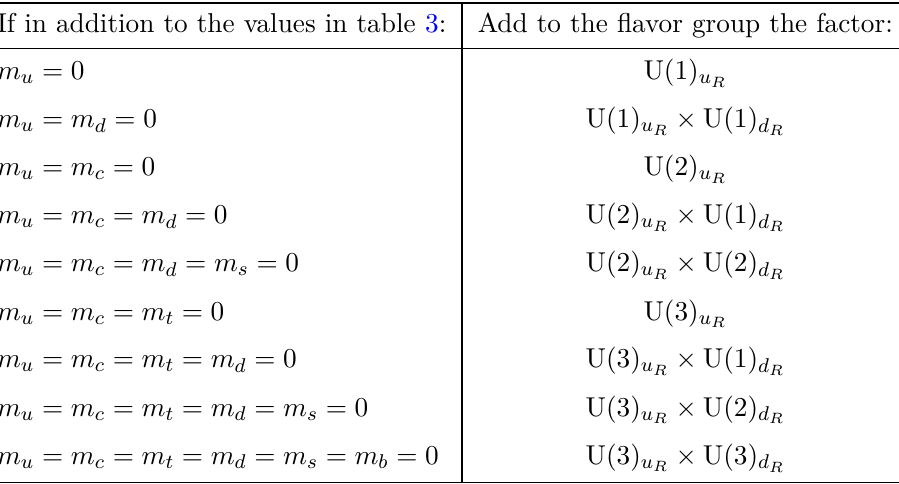
Table 5 . Additional factor to the flavor symmetry of the SM 4 Lagrangian when quark masses